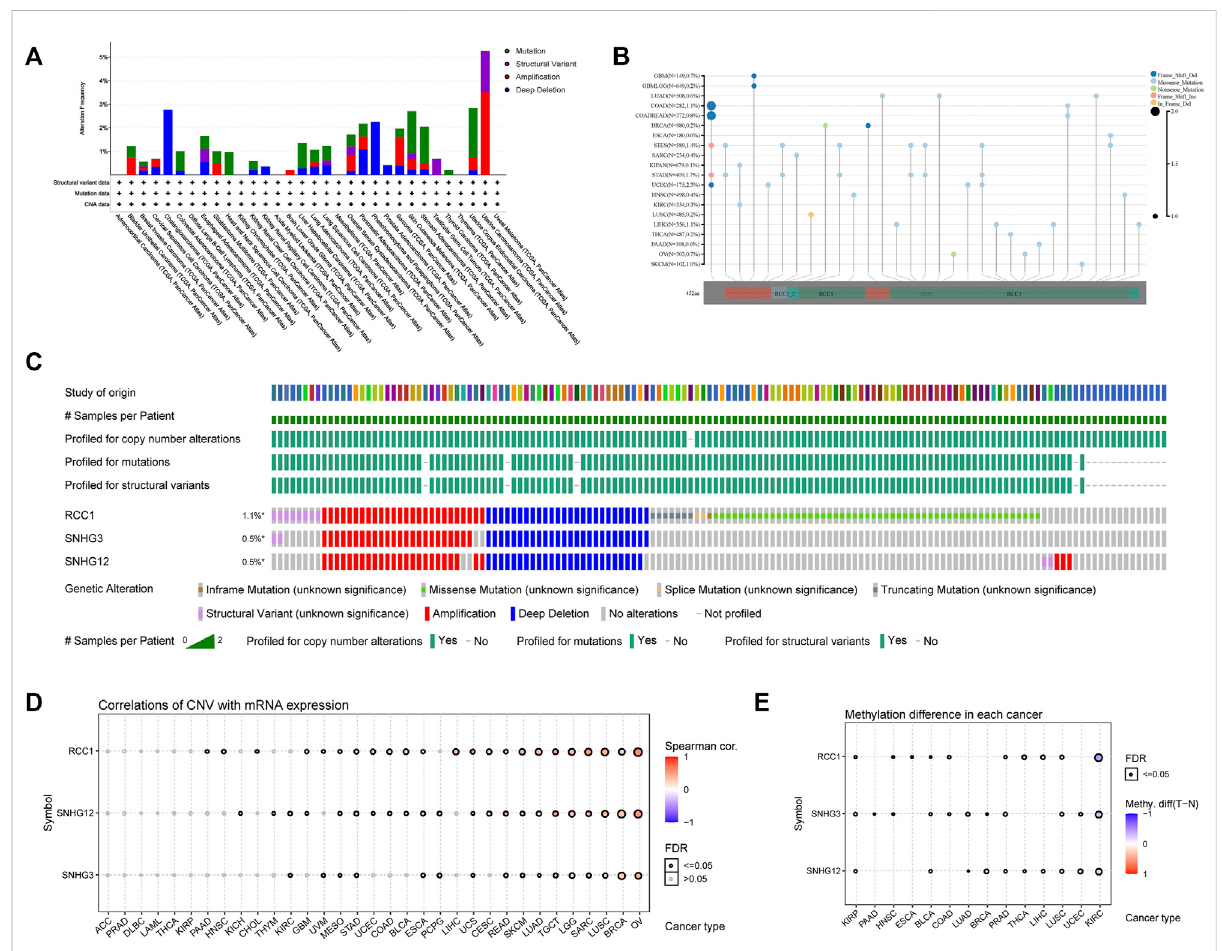
Genetic alternation of RCC1/SNHG3/SNHG12 in different tumors. (A) RCC1 mutation frequency in multiple TCGA pan-cancer studies. (B) MutationdiagramofRCC1indifferentcancertypesacrossproteindomains. (C) GenomealternationofRCC1,SNHG3andSNHG12. (D) Correlationof CNV with mRNA expression. (E) Methylation difference in each